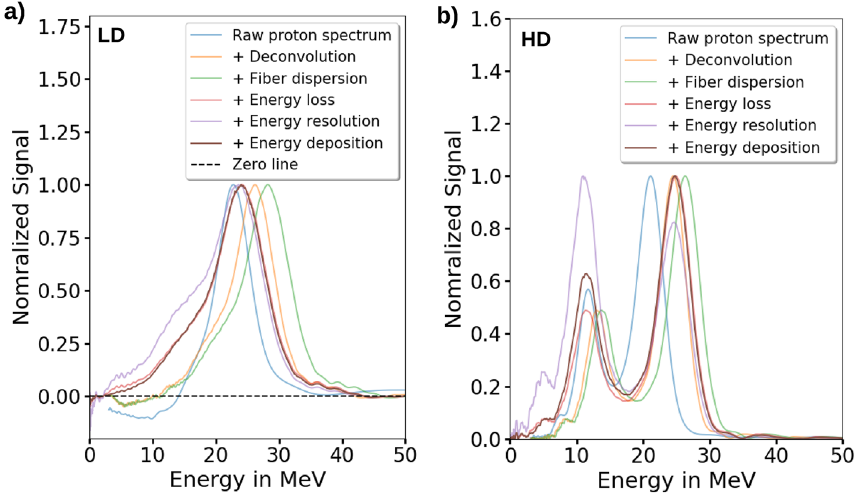
Figure 3. The corrections applied to the time-of-flight (ToF) beam monitoring system (BMS) signal to obtain the relative kinetic proton energy spectrum at the ToF BMS position: Deconvolution with ToF BMS